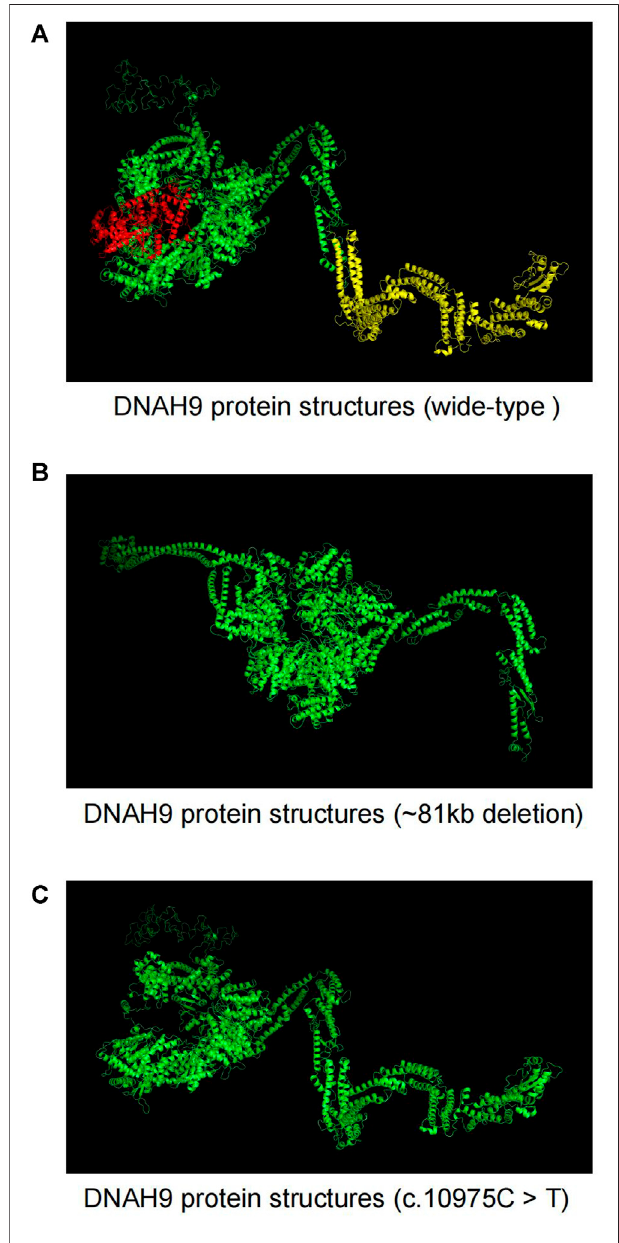
FIGURE 4 | The Effects of DNAH9 mutations on protein structure. (A) The wide-type structure of DNAH9 protein predicted by SWISS-MODEL. The yellow and red parts were modelled using exon 1 – 15 in DNAH9 and amino acid residues from glutamine at position 3,659 to end. The mutant protein structures showed in (B) and (C) upon an 81 kb deletion at chr17p12 (11,486,795 – 11,568,385) or c.10975C > T mutation in DNAH9 ,